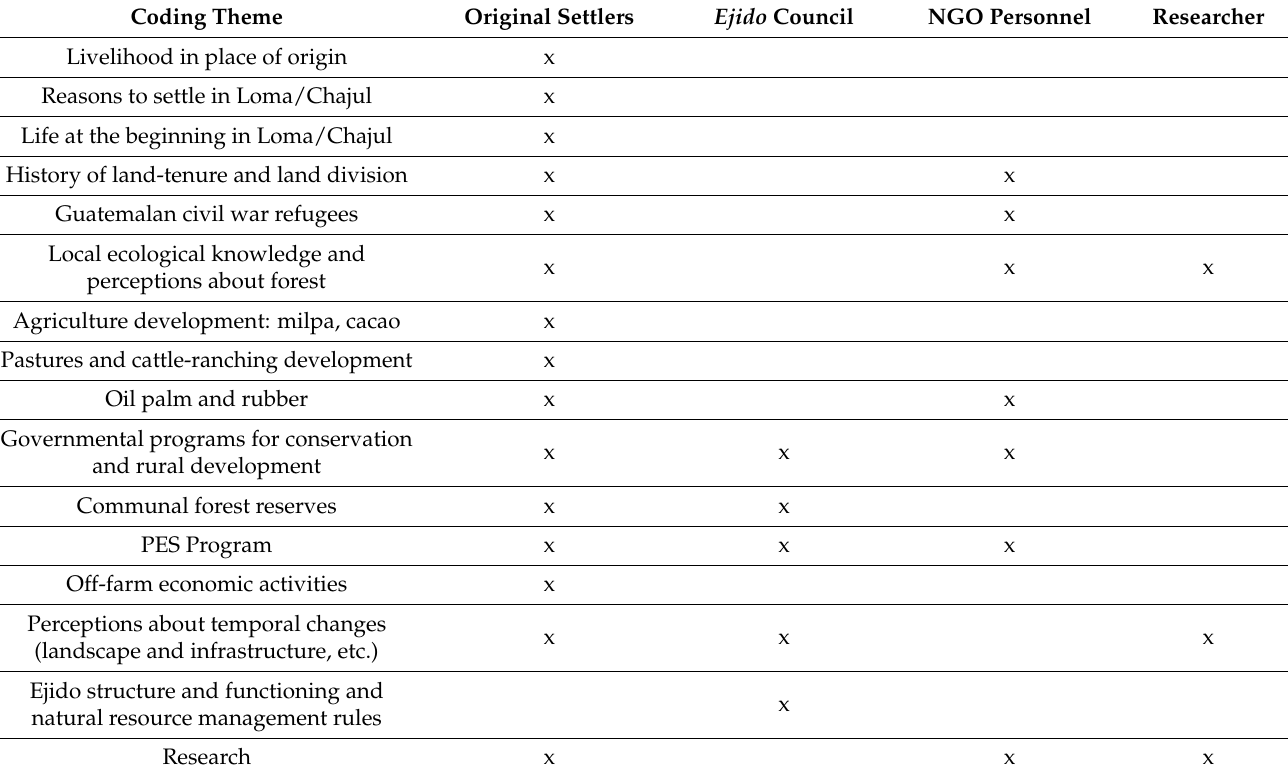
Table 1. Qualitative content analysis coding themes per type of